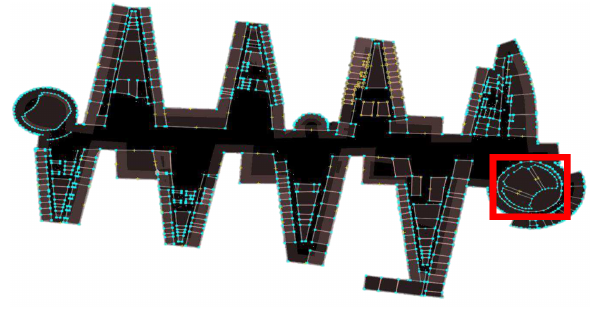
Figure 3. Test area